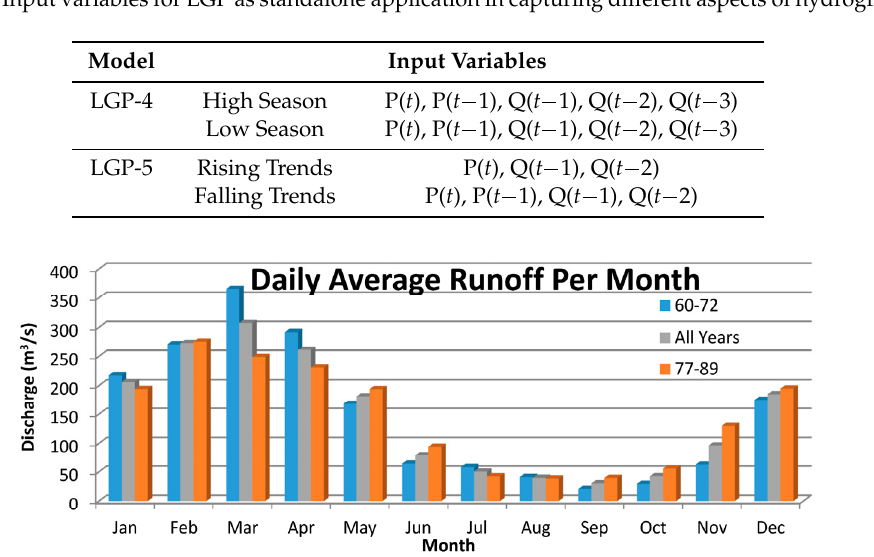
Table 3. Input variables LGP models in hybrid designs untilizing EEMD and SOM.